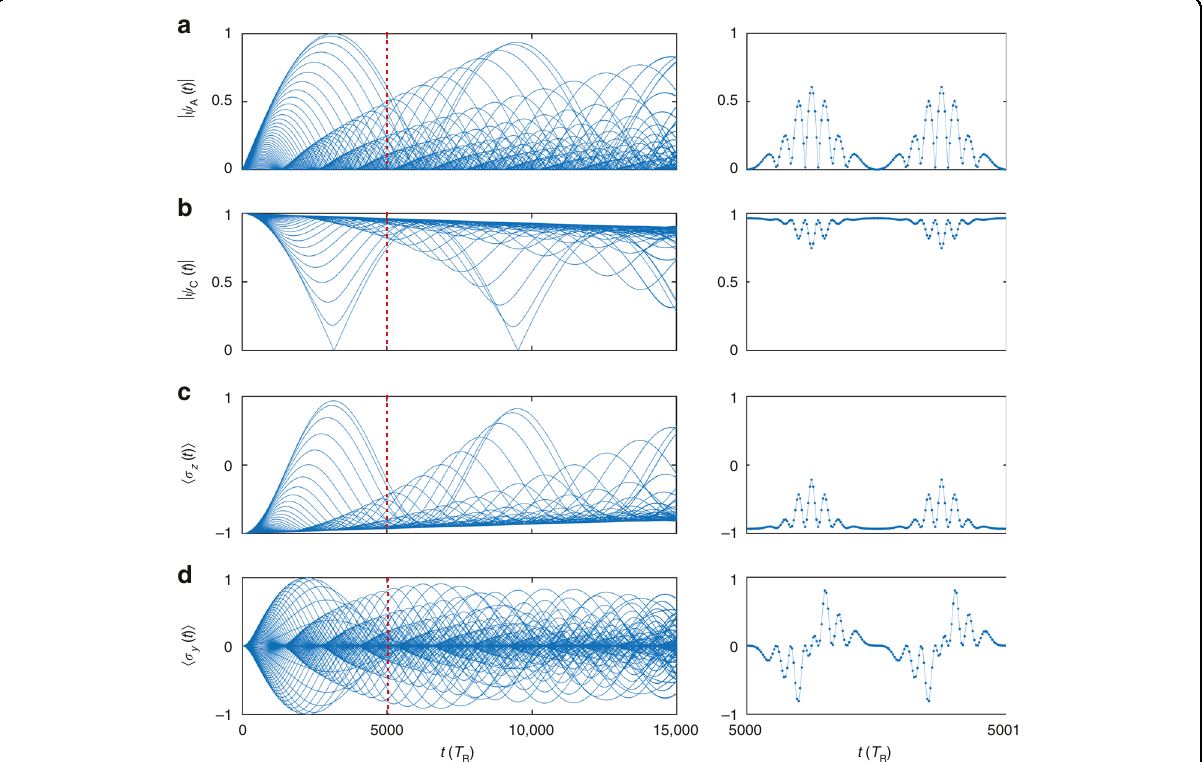
Fig. 2 The electric fi eld amplitudes and spin texture from simulations. a , b The normalized electric fi eld amplitudes ψ A j j and ψ C j j versus discrete time collected from the output waveguides. One hundred and sixty data points are collected in one round-trip ( T R ). c , d The time evolution of (cid:10) (cid:11) ). Right panels are the corresponding zoom-in plots, where data points are connected with lines, showing normalized spin textures ( σ z h i and σ y (cid:10) (cid:11) are evolving continuously along the time that ψ A j j , ψ C j j , σ z h i , and σ y